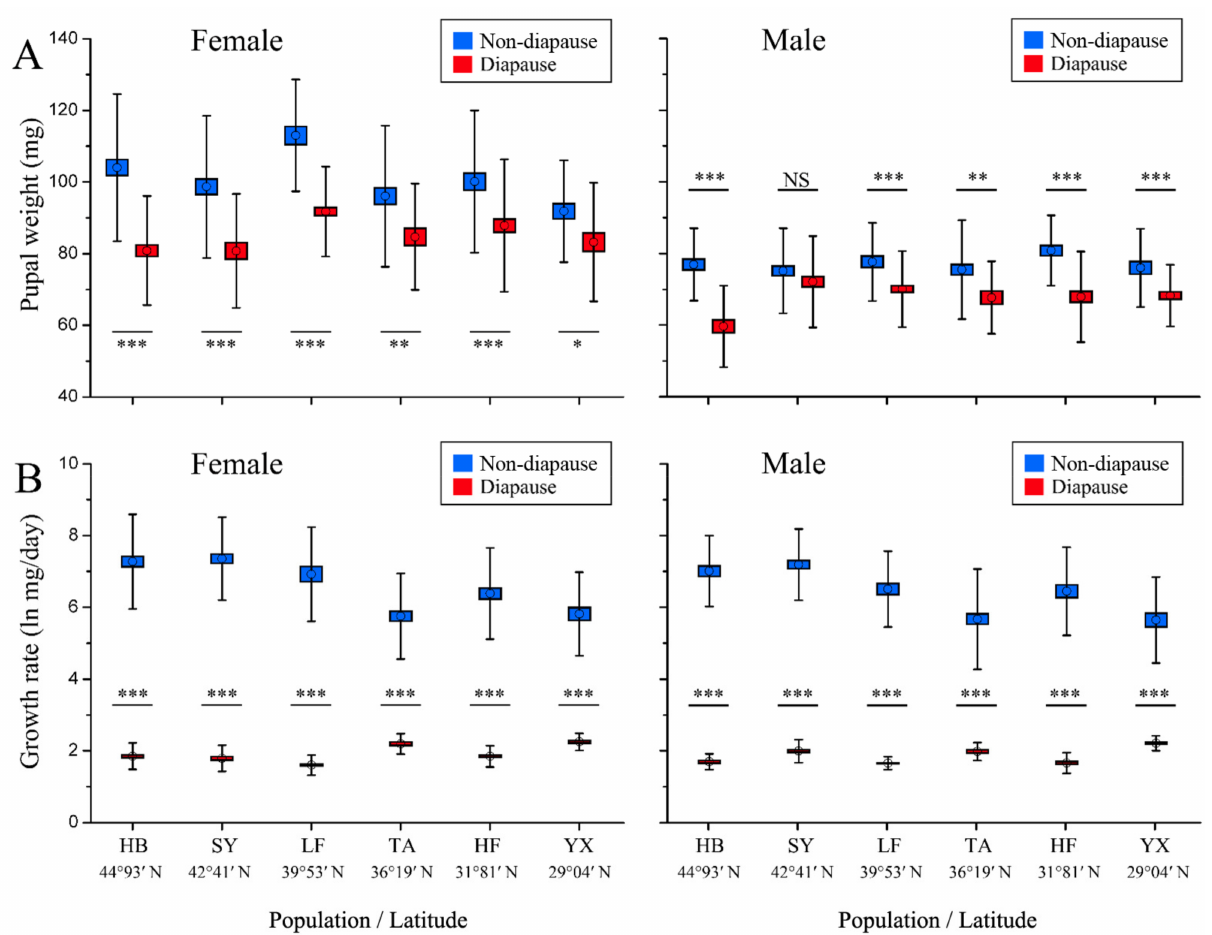
Figure 3. Pupal weight ( A ) and larval growth rate ( B ) for non-diapausing and diapausing individuals in different geographical populations of Ostrinia furnacalis . The asterisk indicates a significant differ- ence between non-diapausing and diapausing individuals in each subgraph (* p ≤ 0.05, ** p ≤ 0.01, *** p ≤ 0.001). NS = Nonsignificant. Error bars indicate